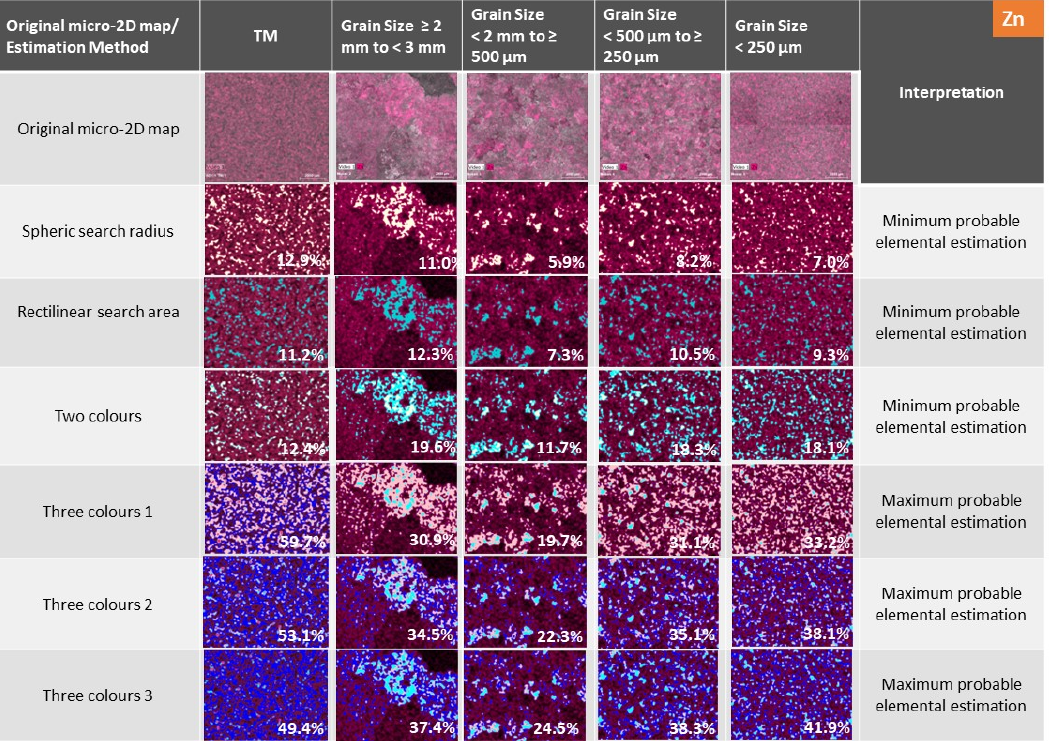
Figure A3. Minimum and maximum probable elemental occurrence in µ-XRF 2D map (percentage of area %) for Cu.